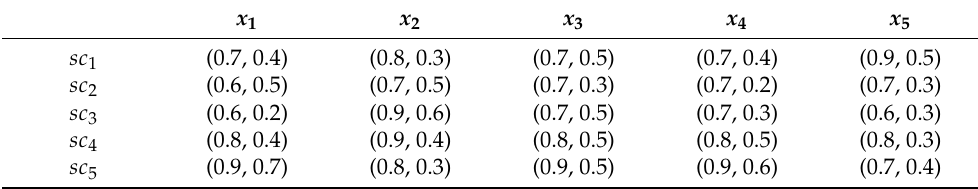
Table 5. Appraisal matrix A 3 by